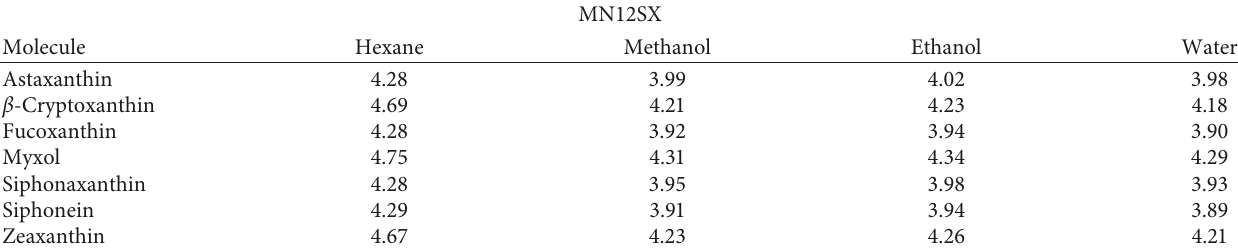
Table 13: Nucleophilicity index N of the carotenoids (in eV) calculated with the MN12SX and N12SX density functionals and the Def2TZVP basis set using hexane, methanol, ethanol, and water as the solvents, simulated with the SMD parametrization of the IEF-PCM